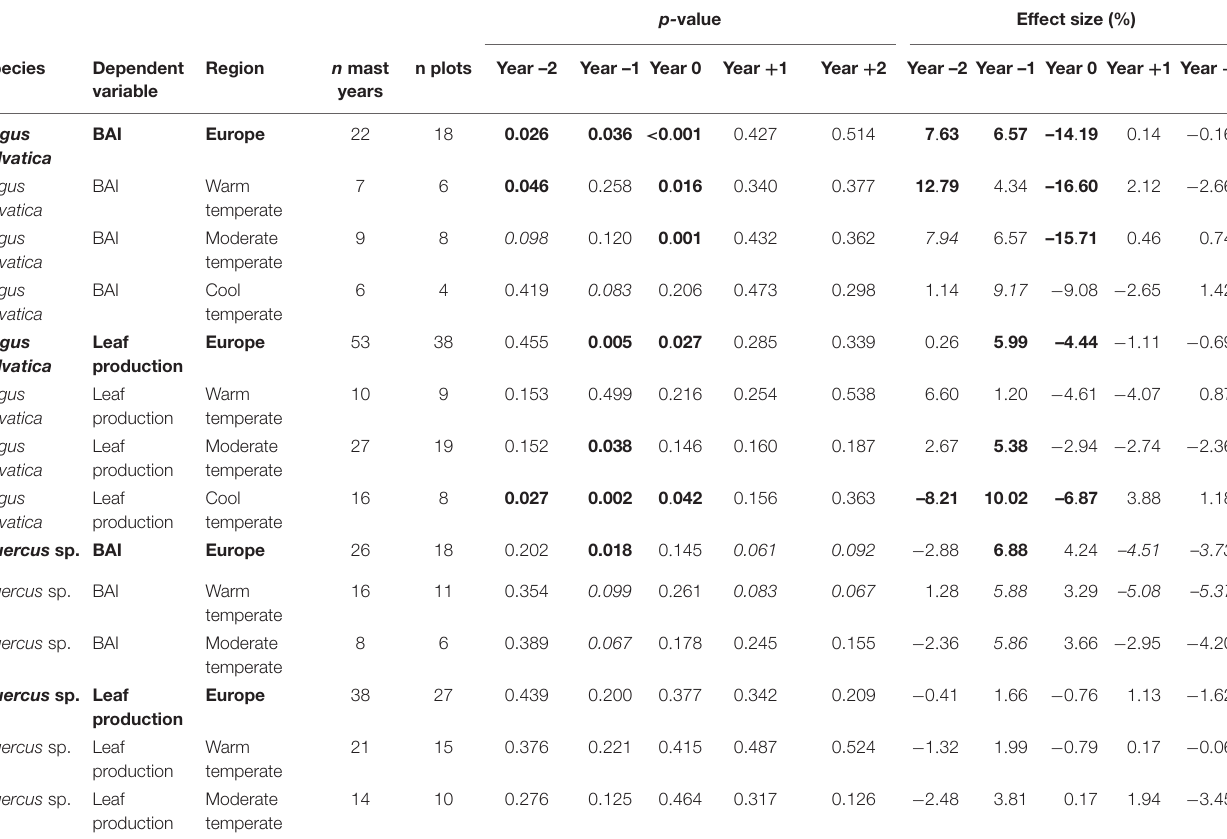
TABLE 1 | Results ( p -values and effect size in %) of the superposed epoch analyses for Europe and climate regions investigating the temporal correlation between fruit production and vegetative growth (basal area increment and leaf production). p- value Effect size (%)